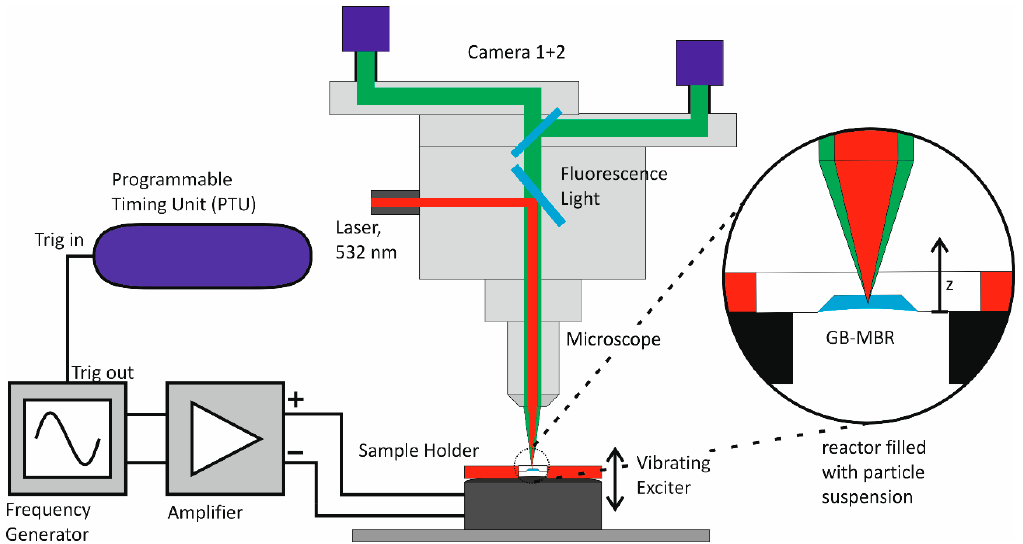
Figure 4. The stereoscopic µPIV setup with exciter and GB-MBR.